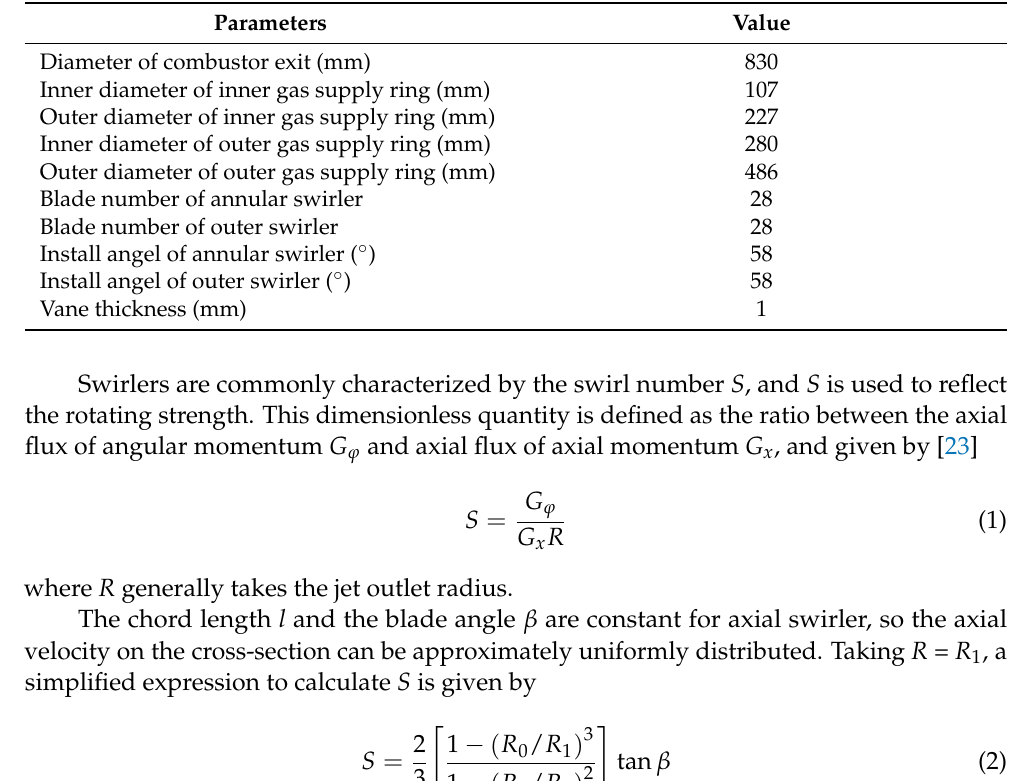
Table 1. The combustor parameters.